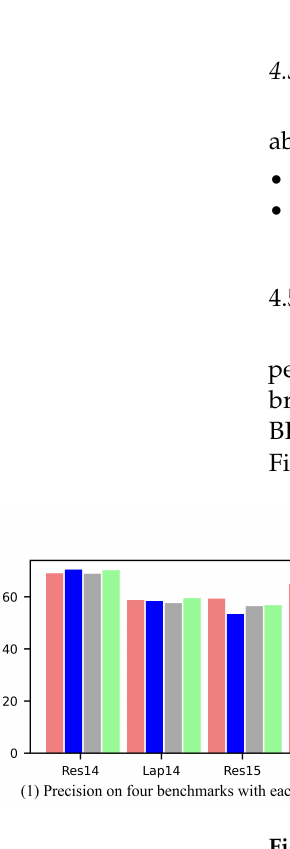
Figure 5. The Results of Ablation Study on V 1 . Res14 means Restaurant14, Lap14 means Laptop14, Res15 denotes Restaurant15, and Res16 denotes Restaurant16.